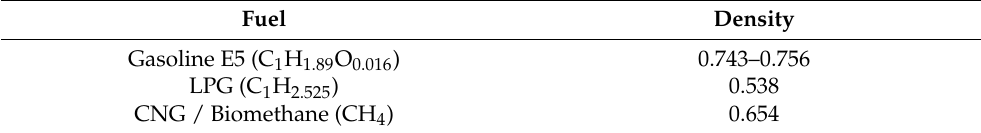
Table 3. Fuel density (kg/dm 3 )